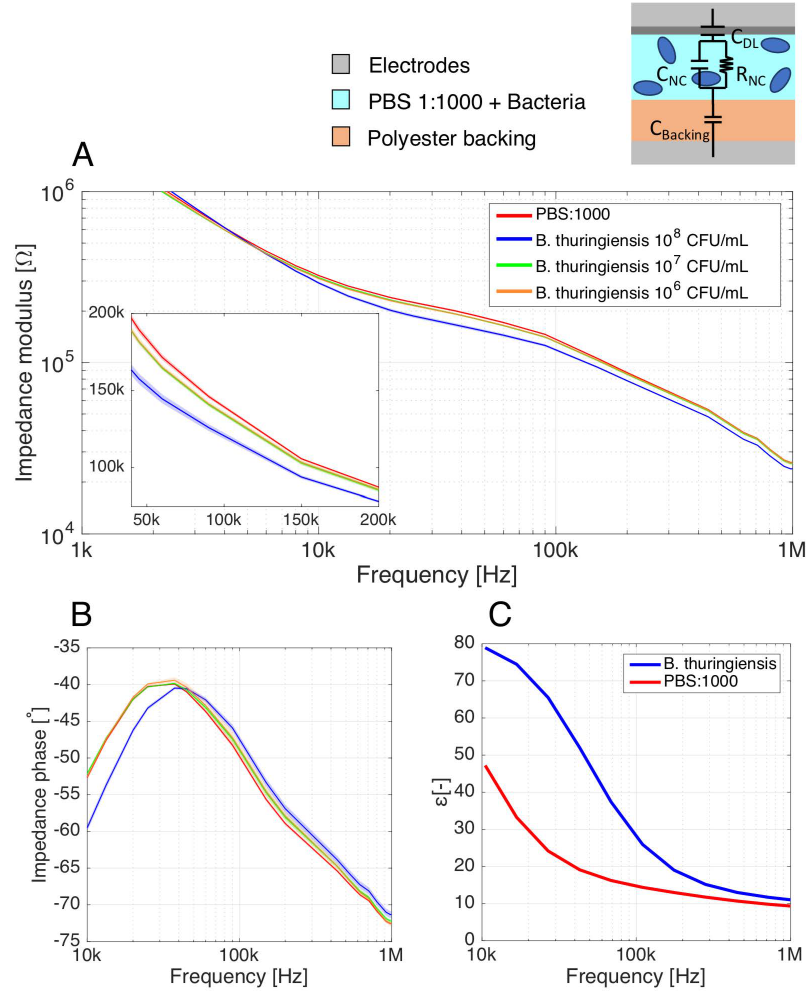
Figure 6. ( A ) Impedance measurements performed on a nitrocellulose (NC) membrane as seen by the parallel-plate setup. The NC membrane is saturated with phosphate-buffered saline (PBS):1000 (reference buffer) or with PBS:1000 containing 10 8 , 10 7 and 10 6 CFU mL − 1 B. thuringiensis cells. The global impedance is experimentally shown to decrease, and the phase is subjected to a shift in presence of bacterial cells in the buffer, showing high similarities with the response of slightly saline solutions. ( B ) The impedance phase evolution over 10 kHz–1 MHz, presenting a phase peak, indicates an interplay of R NC and C NC in the impedance of the system when subjected to bacteria. ( C ) Dielectric permittivity of the system as seen by the parallel-plate setup, when subjected to low-salt buffer with and without bacterial cells. Number of samples: 12 from two independent experiments. Shaded area surrounding the measurements curves: standard deviation ( σ